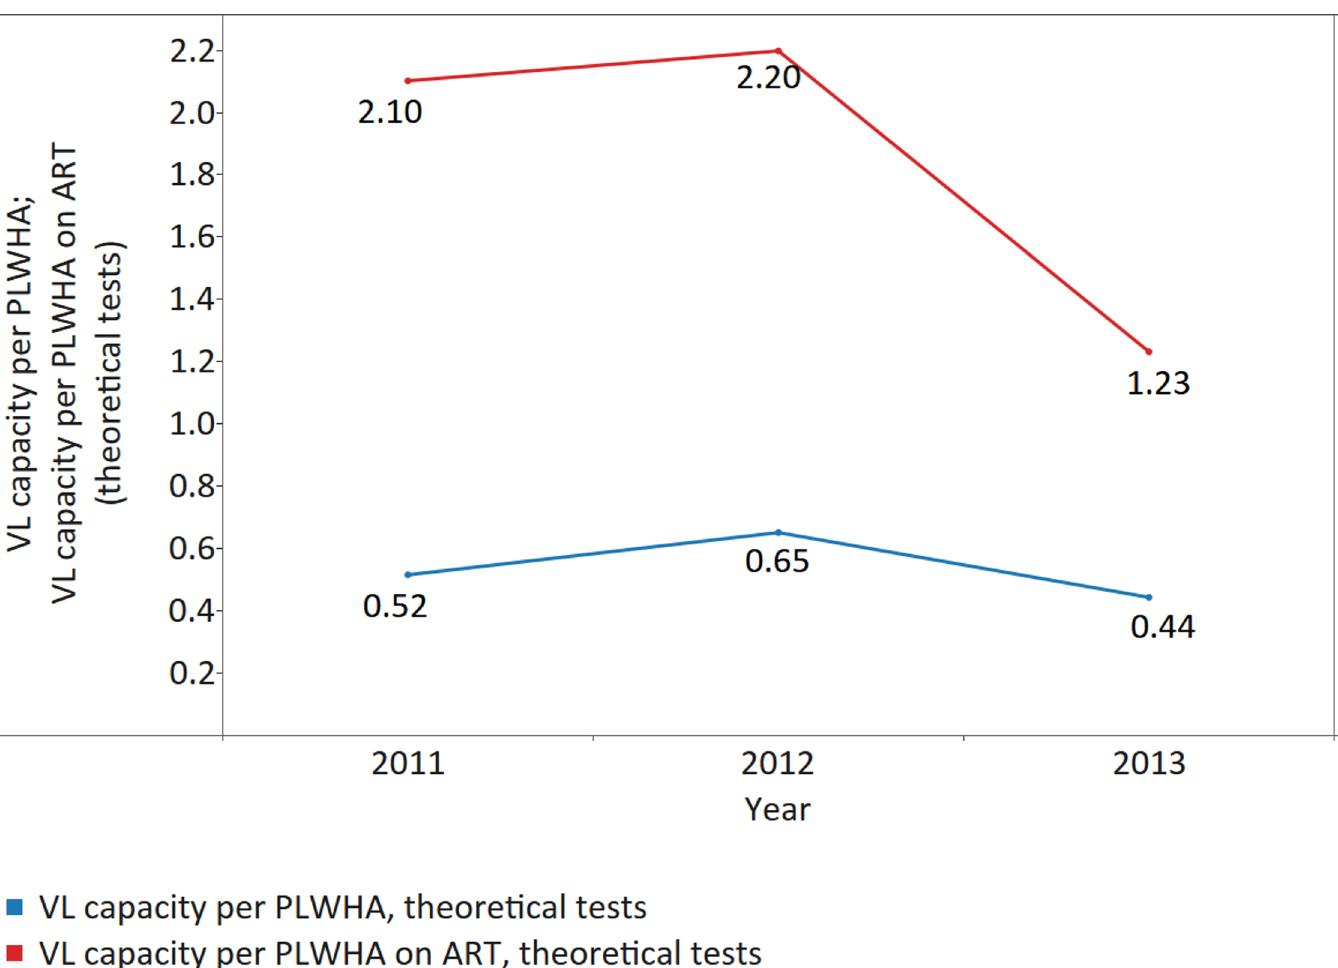
Fig 8. Theoretical viral load (VL) capacity per patient on ART and per PLWHA. Data labels indicate numbers of theoretical tests per year per patient on ART or per